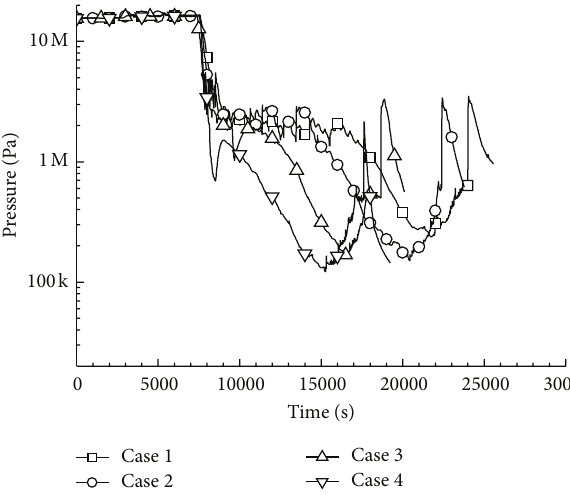
Figure 15: RCS pressure with various valve